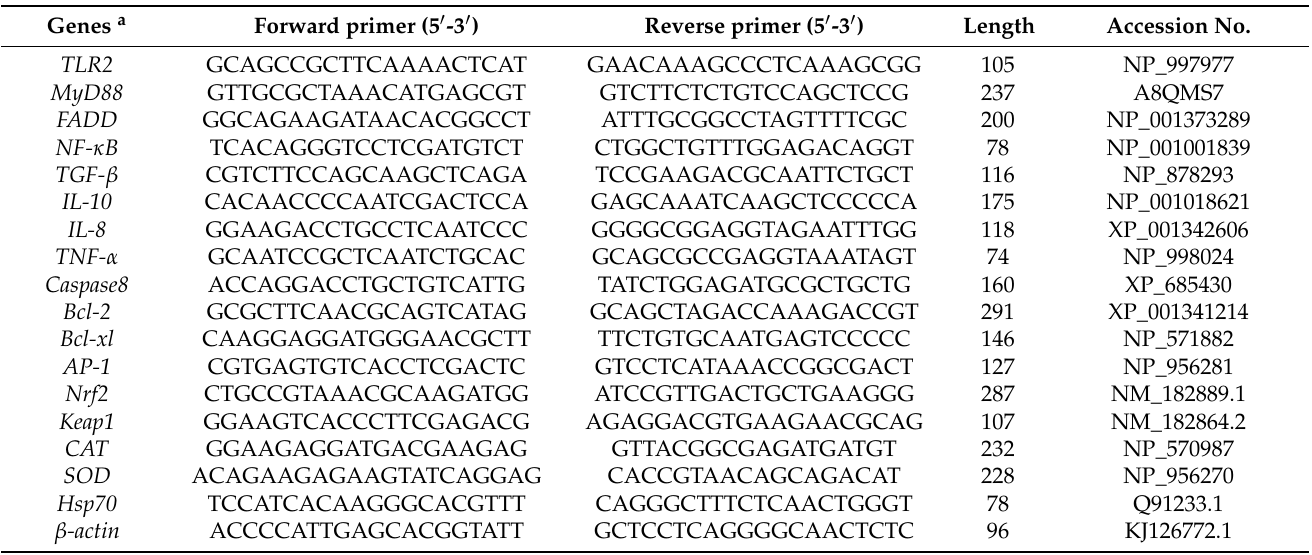
Table 3. Real-time PCR primer